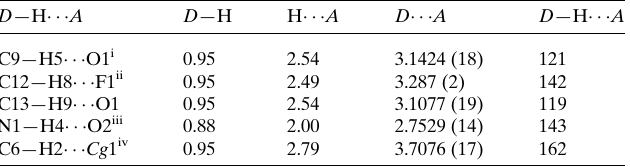
Table 1 Hydrogen-bond geometry (A˚ , (cid:3) ).